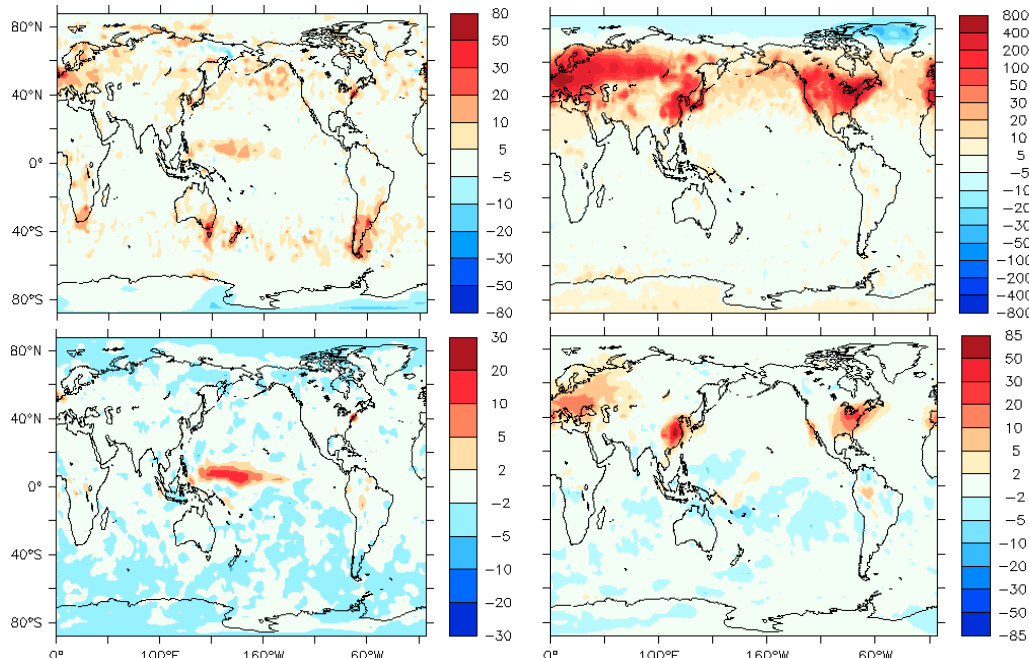
Fig. 16. Monthly average relative enhancements (in %) in OH (upper panel) and ozone (lower panel) near the surface, indicating the difference Figure 16: Monthly average relative enhancements (in %) in OH (upper panel) and ozone between the S2 and base scenarios (relative to the latter) in June (left) and December (lower panel) near the surface, indicating the difference between the S2 and Base scenarios (relative to the latter) in June (left) and December (right).